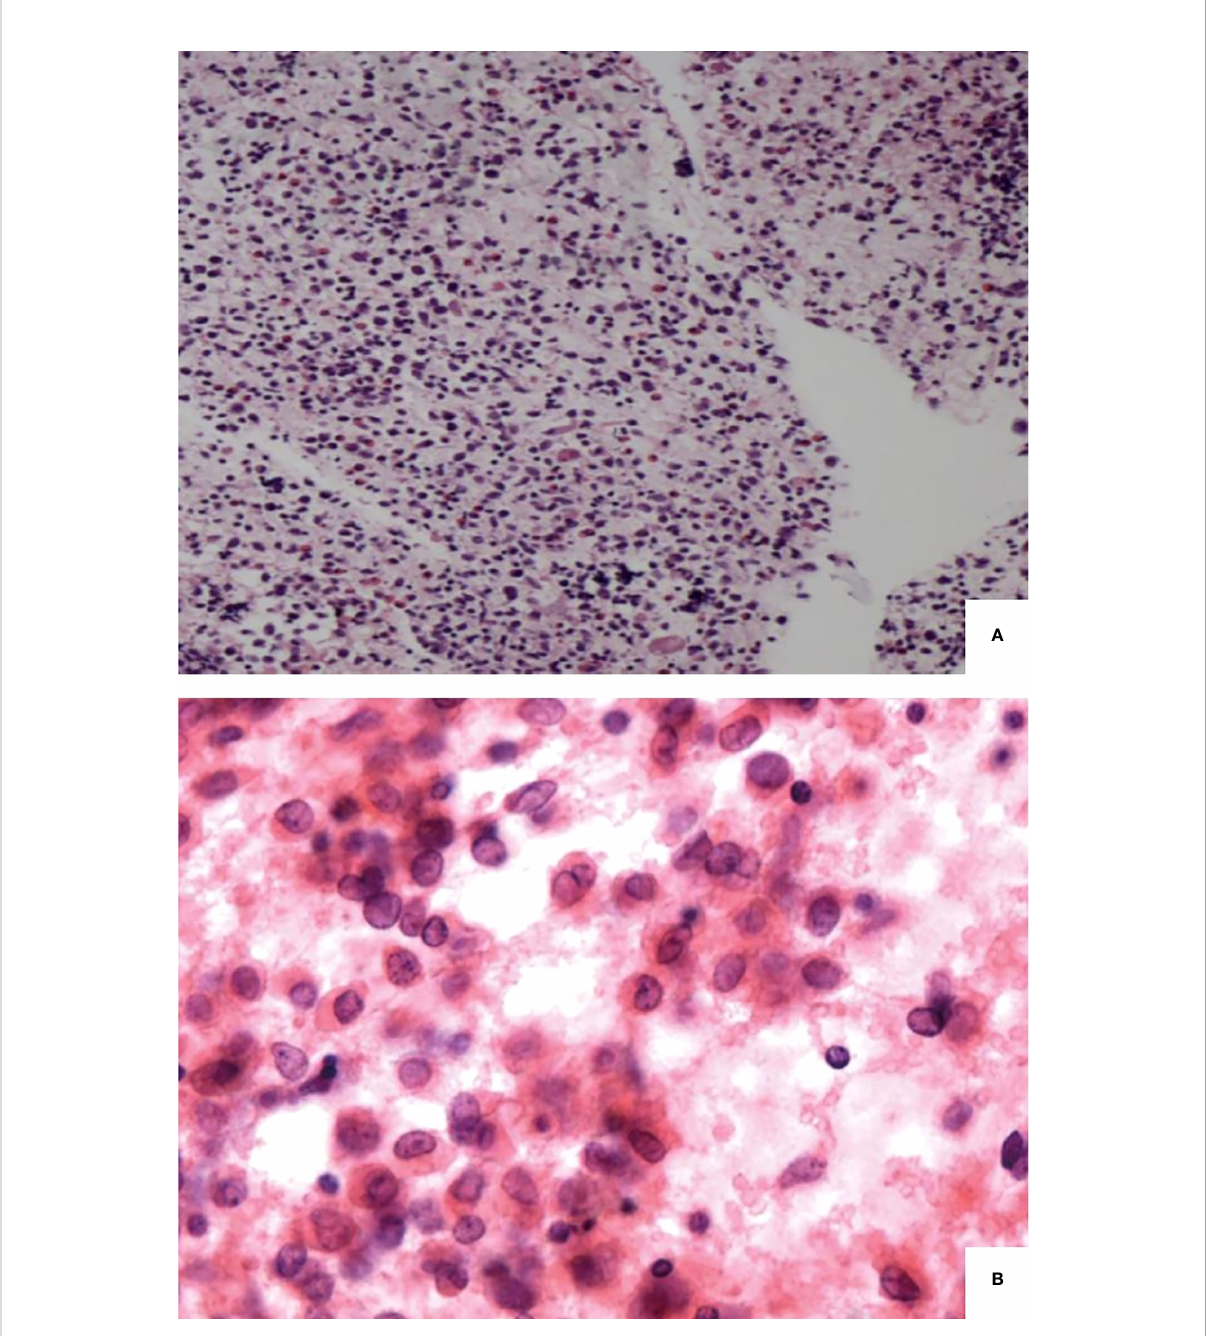
FIGURE 2 Pathological fi ndings of langerhans cell histiocytosis. Langerhans cells admixed with eosinophils and chronic in fl ammatory cells (A) . Langerhans cells with a low nuclear-to-cytoplasmic ratio, irregular nuclear contour and prominent nuclear grooves (B)